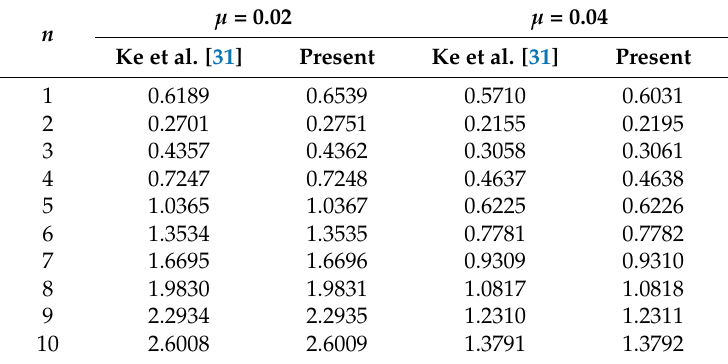
Table 3. Comparison of natural frequency ω (GHz) of a C-SS homogeneous piezoelectric nanoshell ( µ = e 0 a / L ).